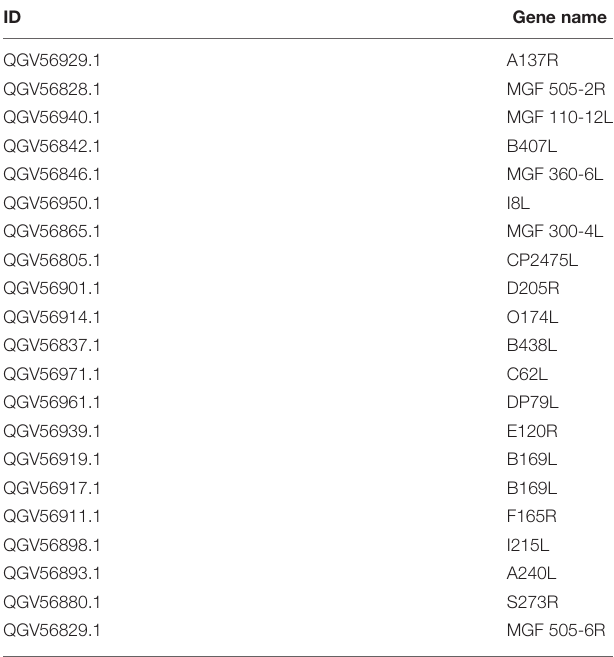
TABLE 3 | ASFV protein contained in ASFV-EVs.